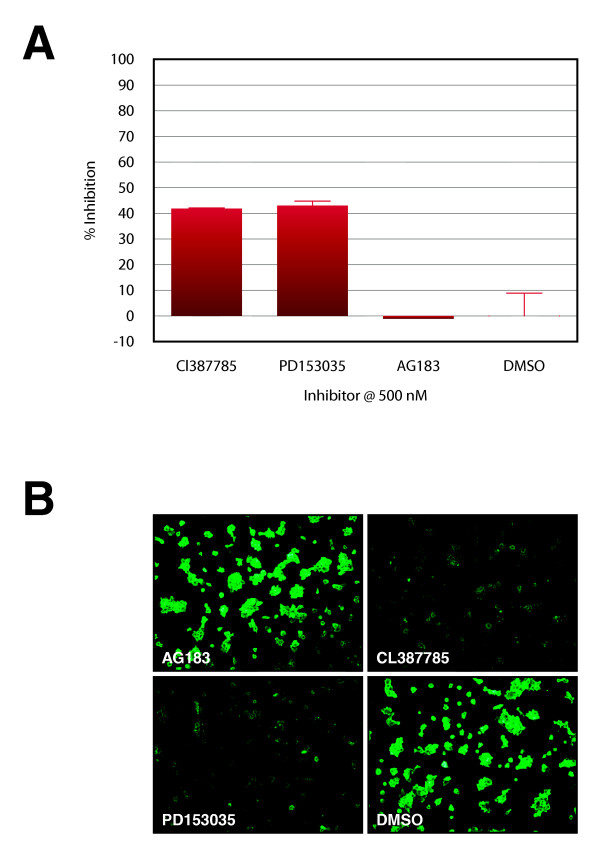
Autophosphorylation of EGFR shows similar inhibition profile as the AP-1-bla ME180 functional cellular assay. Immunocytochemistry with phospho-specific antibodies demonstrates the same inhibition profile as the AP-1 activation assay performed using the ME180 CellSensor. Fluorescence was measured from the Alexa fluor 488 and 594 labelled secondary antibodies used for detection (Panel A). Percent inhibition was determined in comparison to untreated sample and represents the mean of (± SEM) eight independent data points (n = 8). Images were obtained from the Alexa fluor 488 labelled secondary antibody under fluorescent microscopy (Panel B).